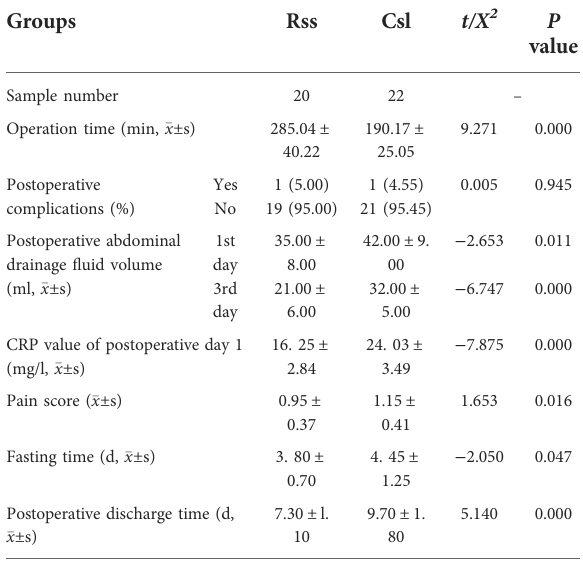
TABLE 2 Comparison of intraoperative and postoperative conditions of the two surgical